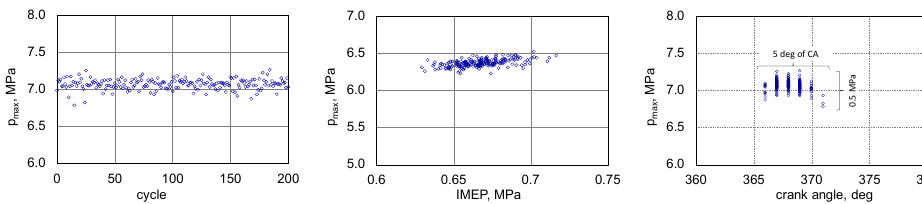
Figure 3. Example of uniqueness of p max (fuel BB80).